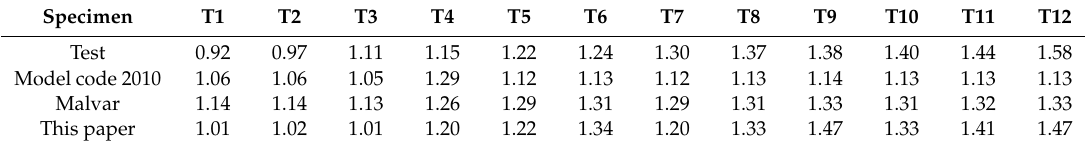
Figure 12. DIF (dynamic increase factor) curves and experimental data. Table 6. Comparison of the obtained DIF and the fitted results.